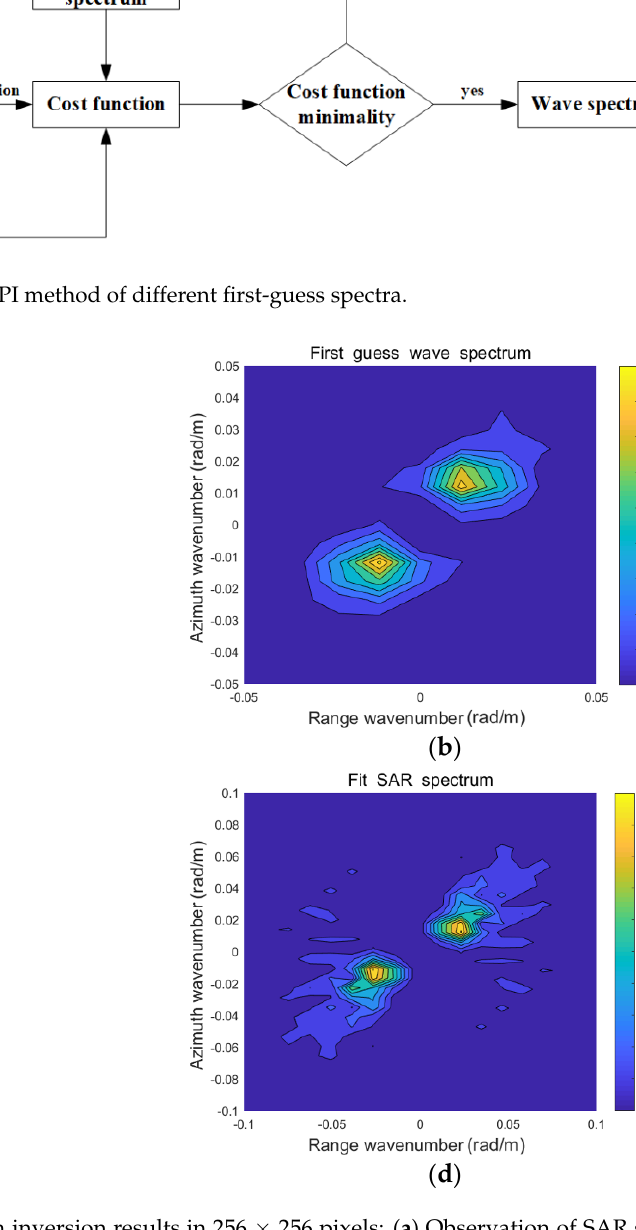
Figure 4. Flowchart of MPI method of different first-guess spectra.